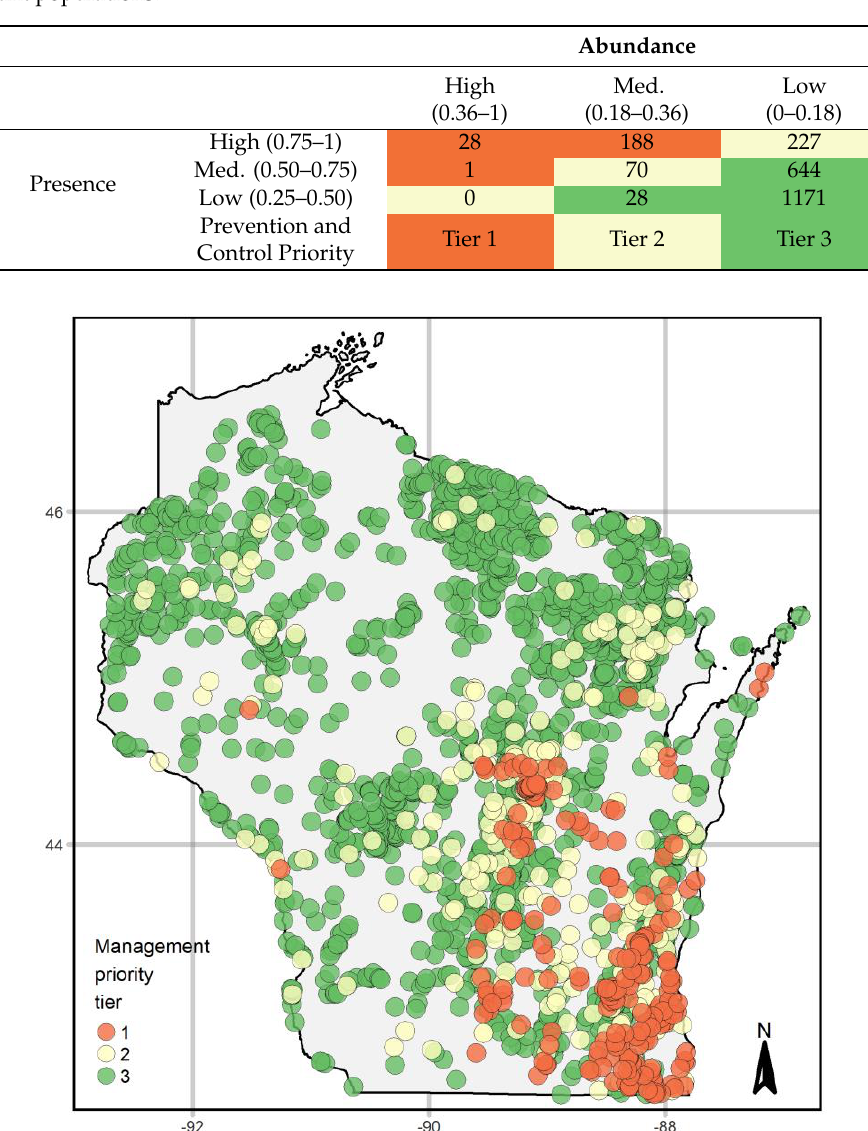
Figure 4. Management priority tiers based on modelled risk of EWM occurrence and abundance following the prioritization matrix in Table 4. Lakes shown are those not known to contain EWM currently, but where occurrence models predicted it is likely to occur. Tier 1 (orange) lakes are the most vulnerable. They are likely to support EWM at high abundance and have top priority for prevention and management. Tier 2 lakes include those with moderate risk for EWM invasion and abundance. Tier 3 lakes are less likely to have EWM populations and are also unlikely to support abundant